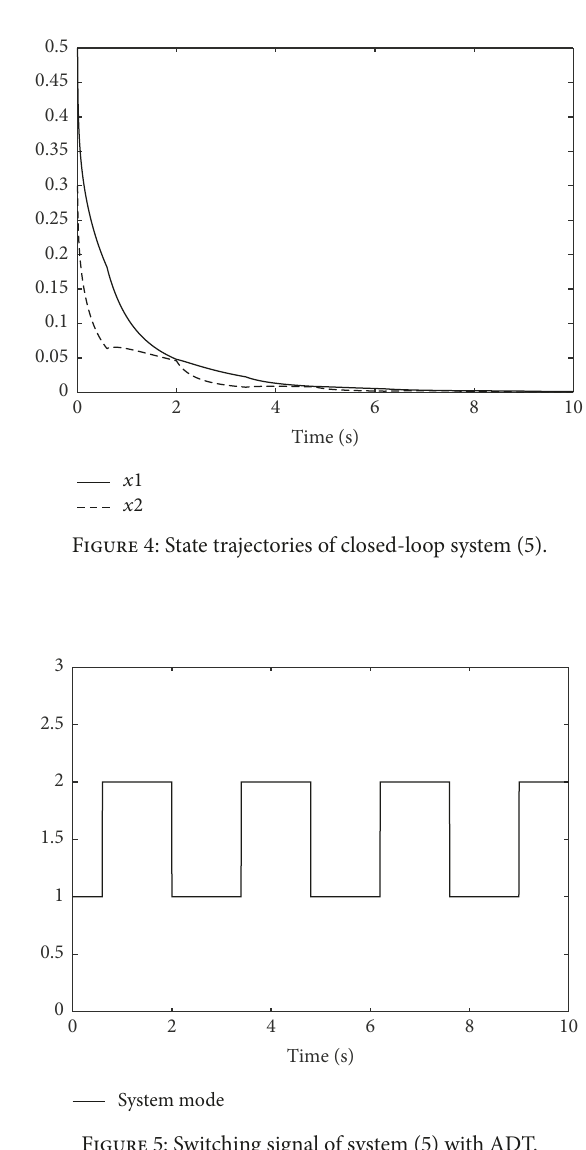
Figure 5: Switching signal of system (5) with ADT.